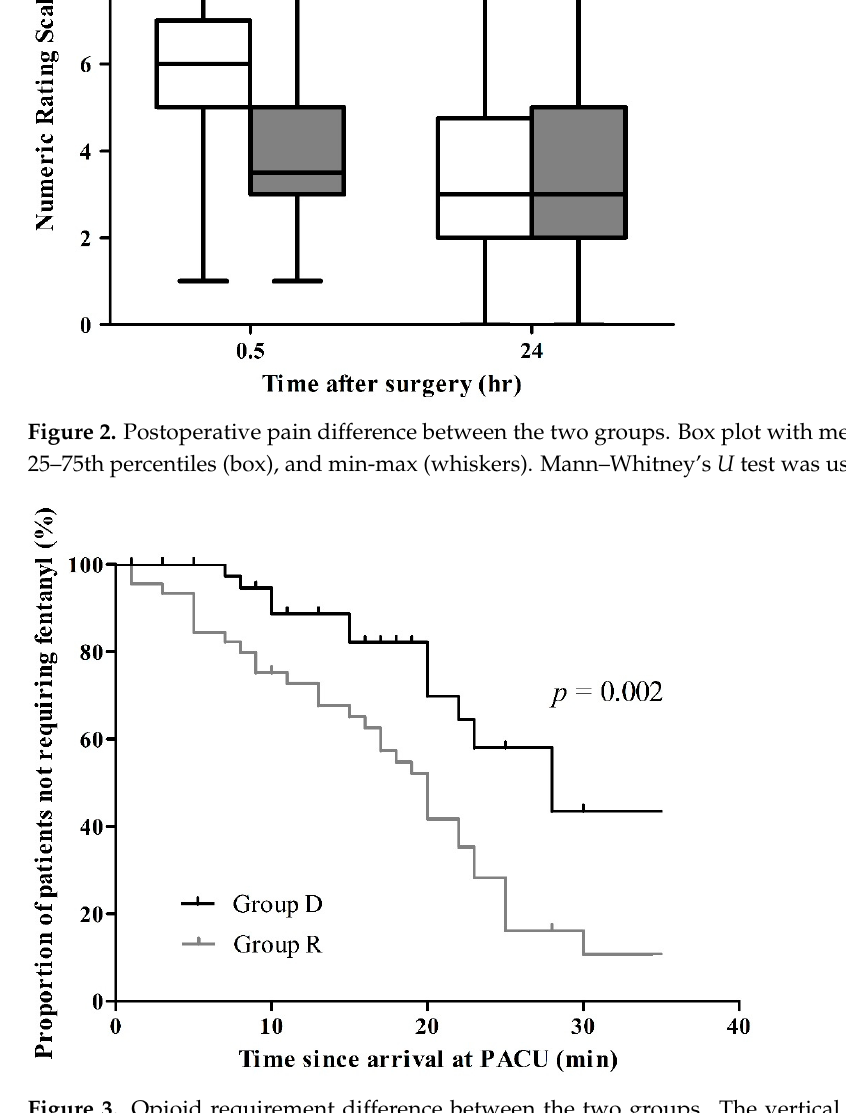
Figure 3. Opioid requirement difference between the two groups. The vertical upticks indicate the occurrence of events (opioid requirement). Kaplan–Meier analysis was performed. PACU, Post-anesthetic care unit.